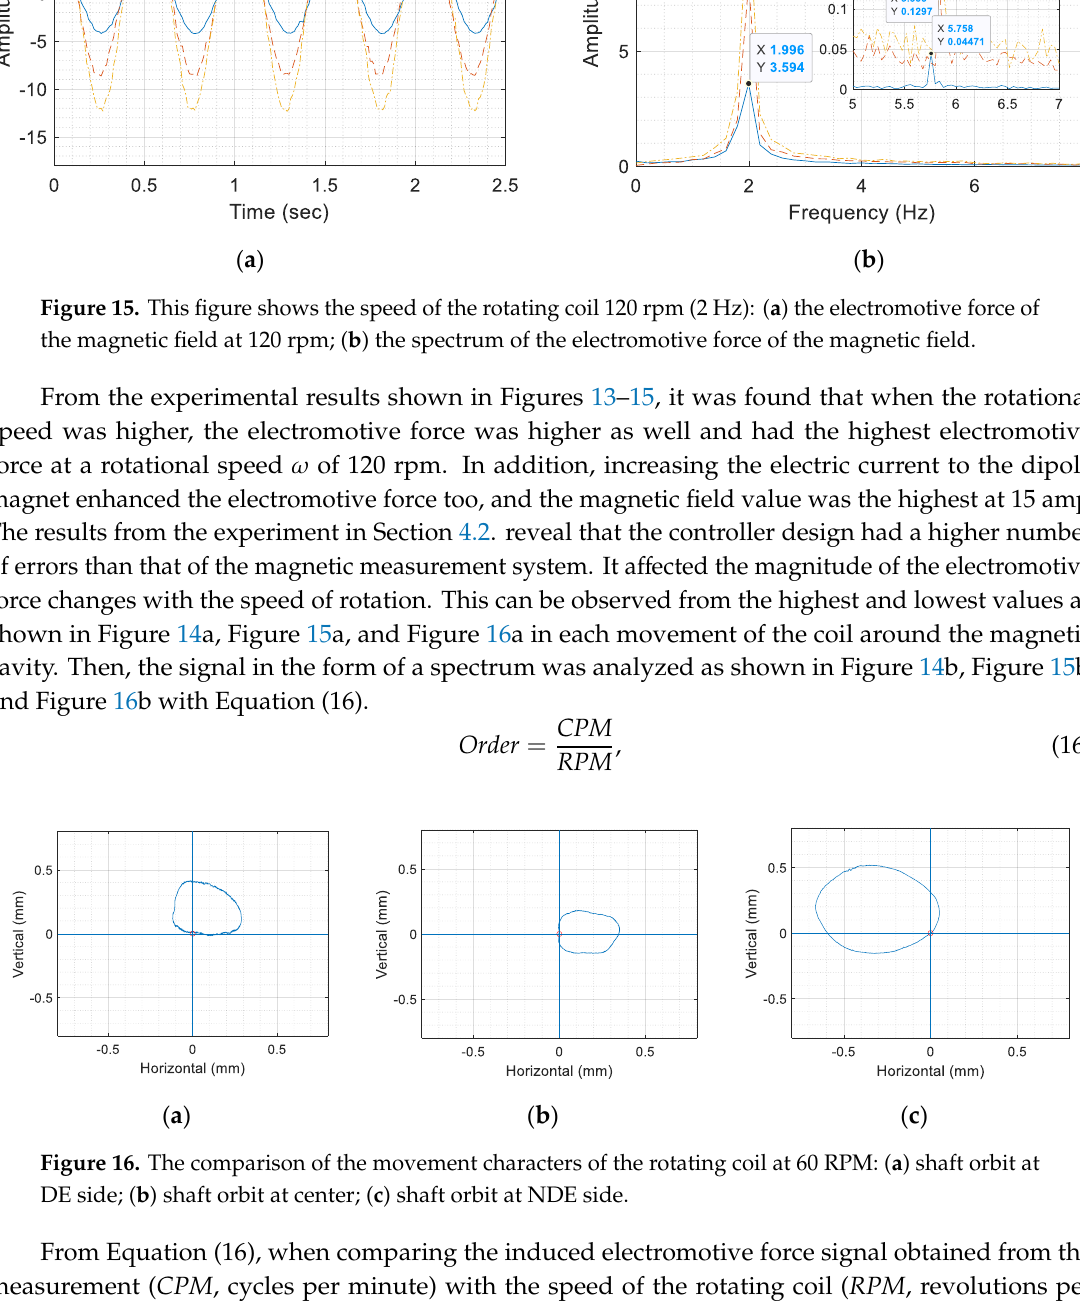
Figure 17. The comparison of the movement characters of the rotating coil at 90 RPM: ( a ) shaft orbit at the DE side; ( b ) shaft orbit at the center; ( c ) shaft orbit at the NDE side.